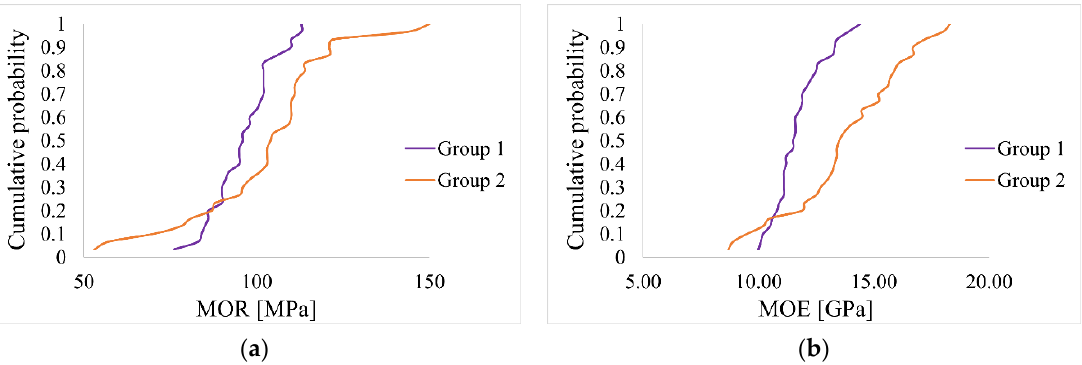
Figure 13. Empirical cumulative distribution function: ( a ) MOR, ( b ) MOE.